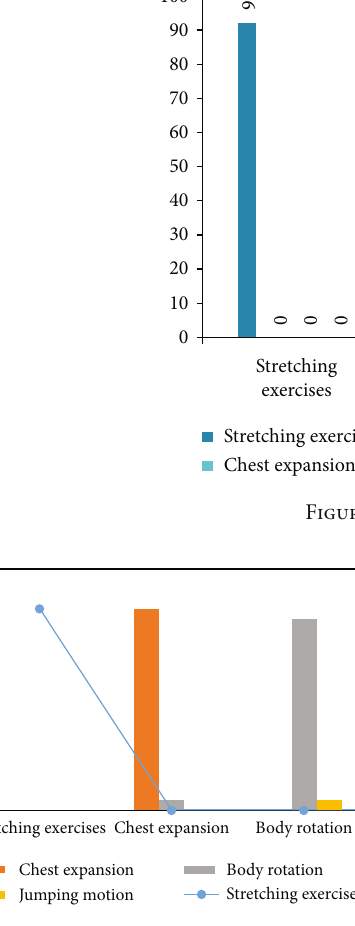
Figure 8: Matrix mean analysis of UTKinect dataset. Figure